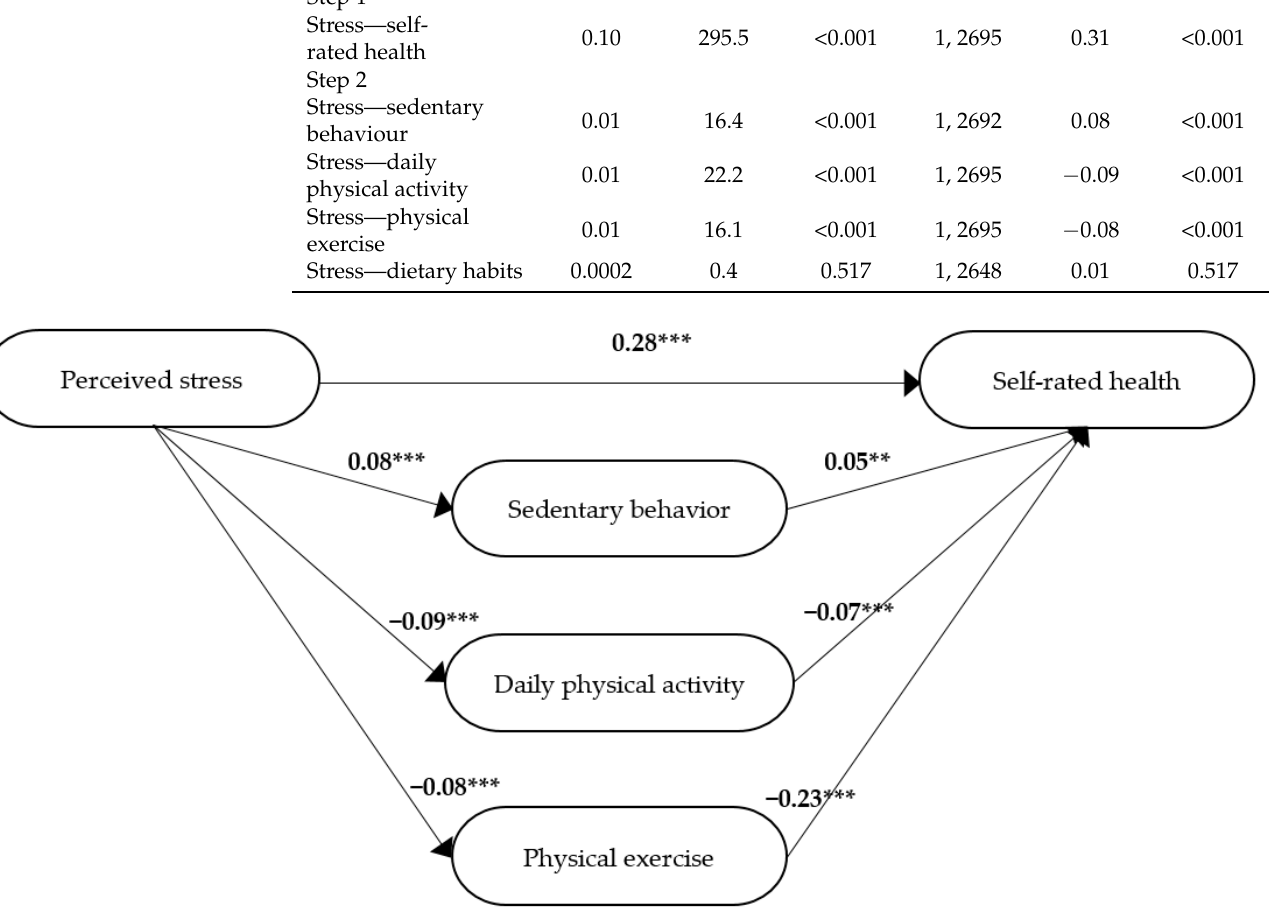
Figure 5. The final model for participants who reported having one of the requested diagnoses. The standardized beta coefficients ( β ) for the different paths between the independent variable, i.e., perceived stress, the mediators, i.e., sedentary behaviour, daily physical activity, and physical exercise, and the dependent variable, i.e., self-rated health. ** p ≤ 0.01, *** p ≤ 0.001.